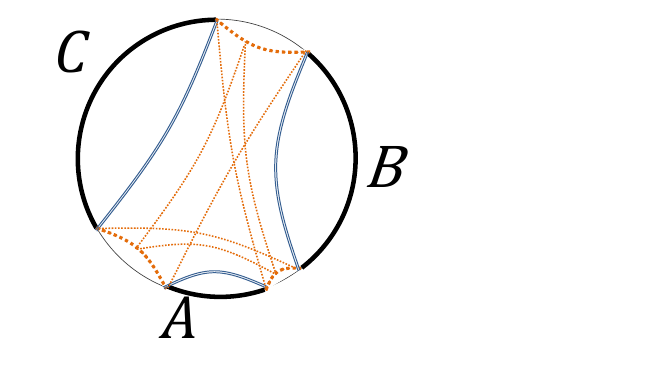
Figure 6 . The proof of a lower bound of (cid:1) W . The sum of dashed yellow lines is (cid:1) ABC + S AB + S BC + S CA , and the sum of real doubled blue lines are 2( S A + S B + S C ). Clearly (cid:1) W + S AB + S BC + S CA (cid:21) 2( S A + S B + S C ) follows, since the entanglement entropy are de(cid:12)ned as minimal